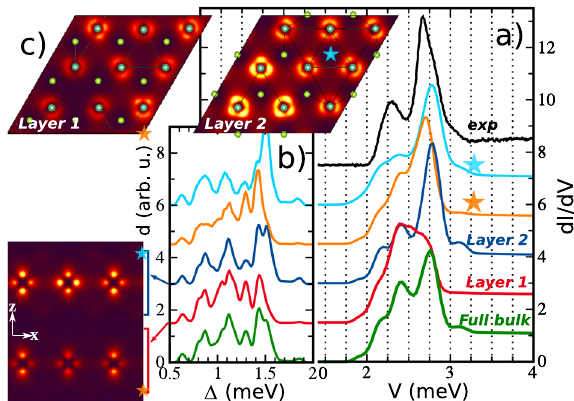
Fig. 5 Simulated real-space superconducting gap and STM spectra. a Simulated differential-conductance spectra of NbSe 2 for the bulk (green), layer L 1 (red), layer L 2 (dark blue) and at the experimental positions of Fig. 1a (orange, light blue). Experimental spectrum (black) obtained by averaging over multiple data traces as in Supplementary Fig. 4b. Tunneling currents are computed from the real-space distributions of gap values shown in ( b ), where Δ is = T scaled by the factor T exp c to correct for the overestimation of T c . c c Real-space view of the superconducting gap, showing stronger superconductivity on L 2 , especially at speci fi c Nb sites (bright